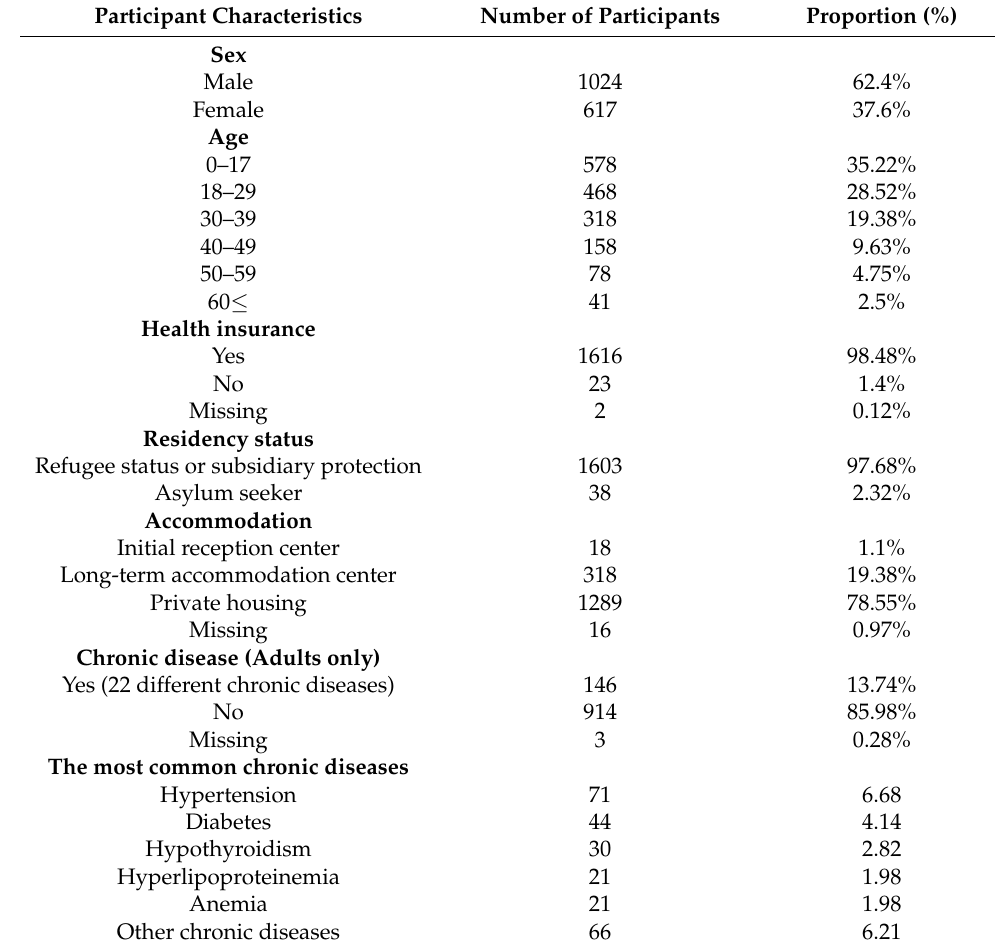
Table 1. Sociodemographic characteristics of the study